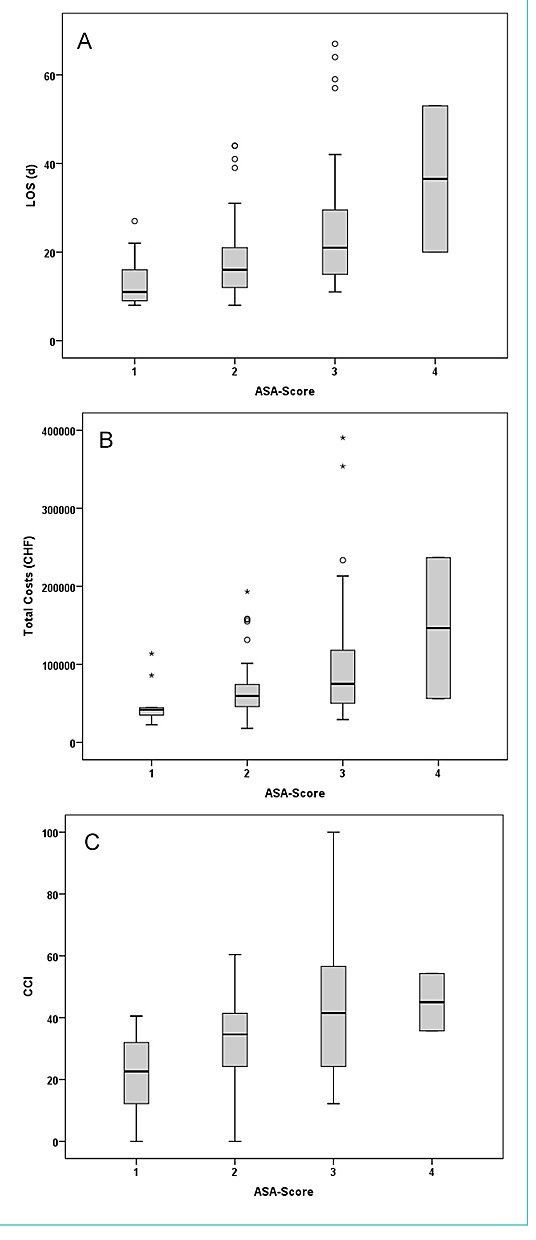
Figure 2: Box plots of patient outcomes by pre-surgical American Society of Anesthesiologists (ASA) score: (above) length of stay (LOS) in days, (centre) total inpatient costs per case, and compre- hensive complication index (CCI) points (below). n =